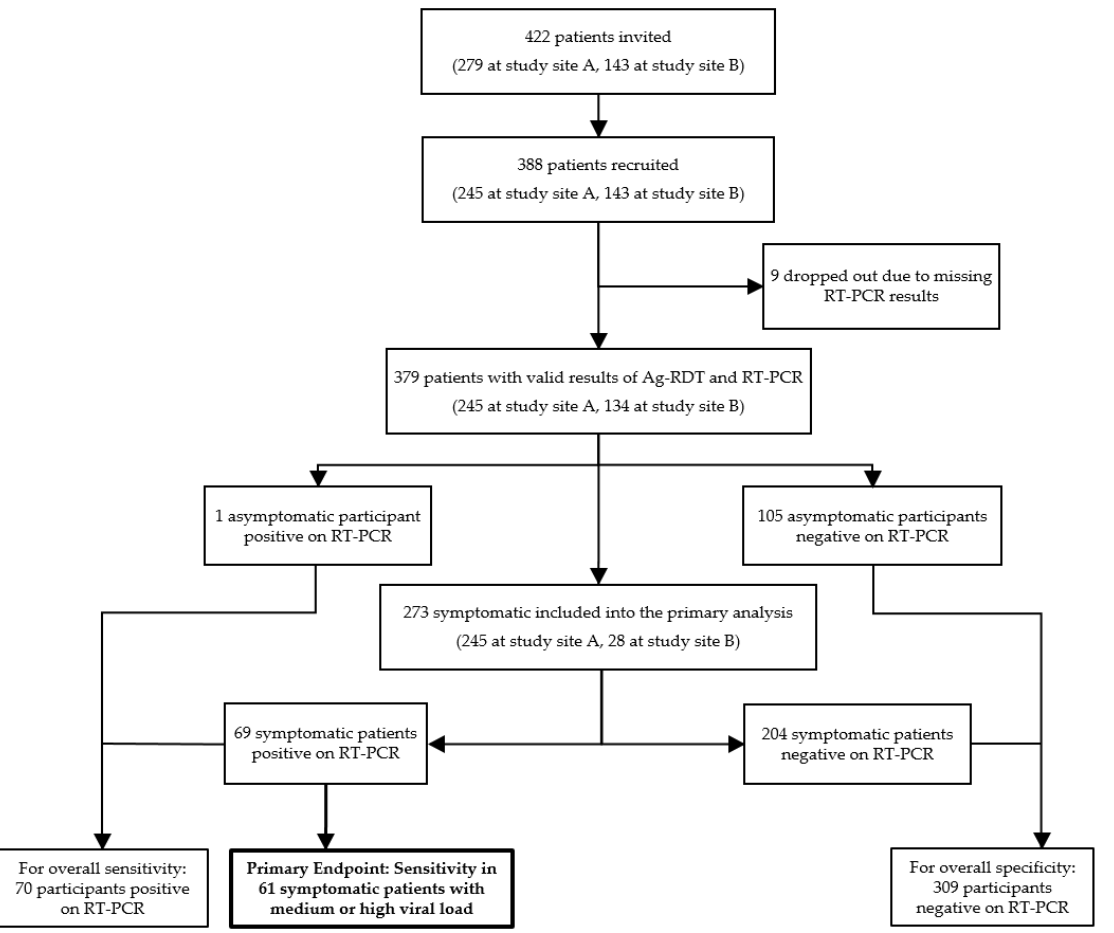
Figure 2. Participant flow diagram. RT-PCR: Real-time polymerase chain reaction; Ag-RDT: Antigen-detecting rapid diagnostic tests.